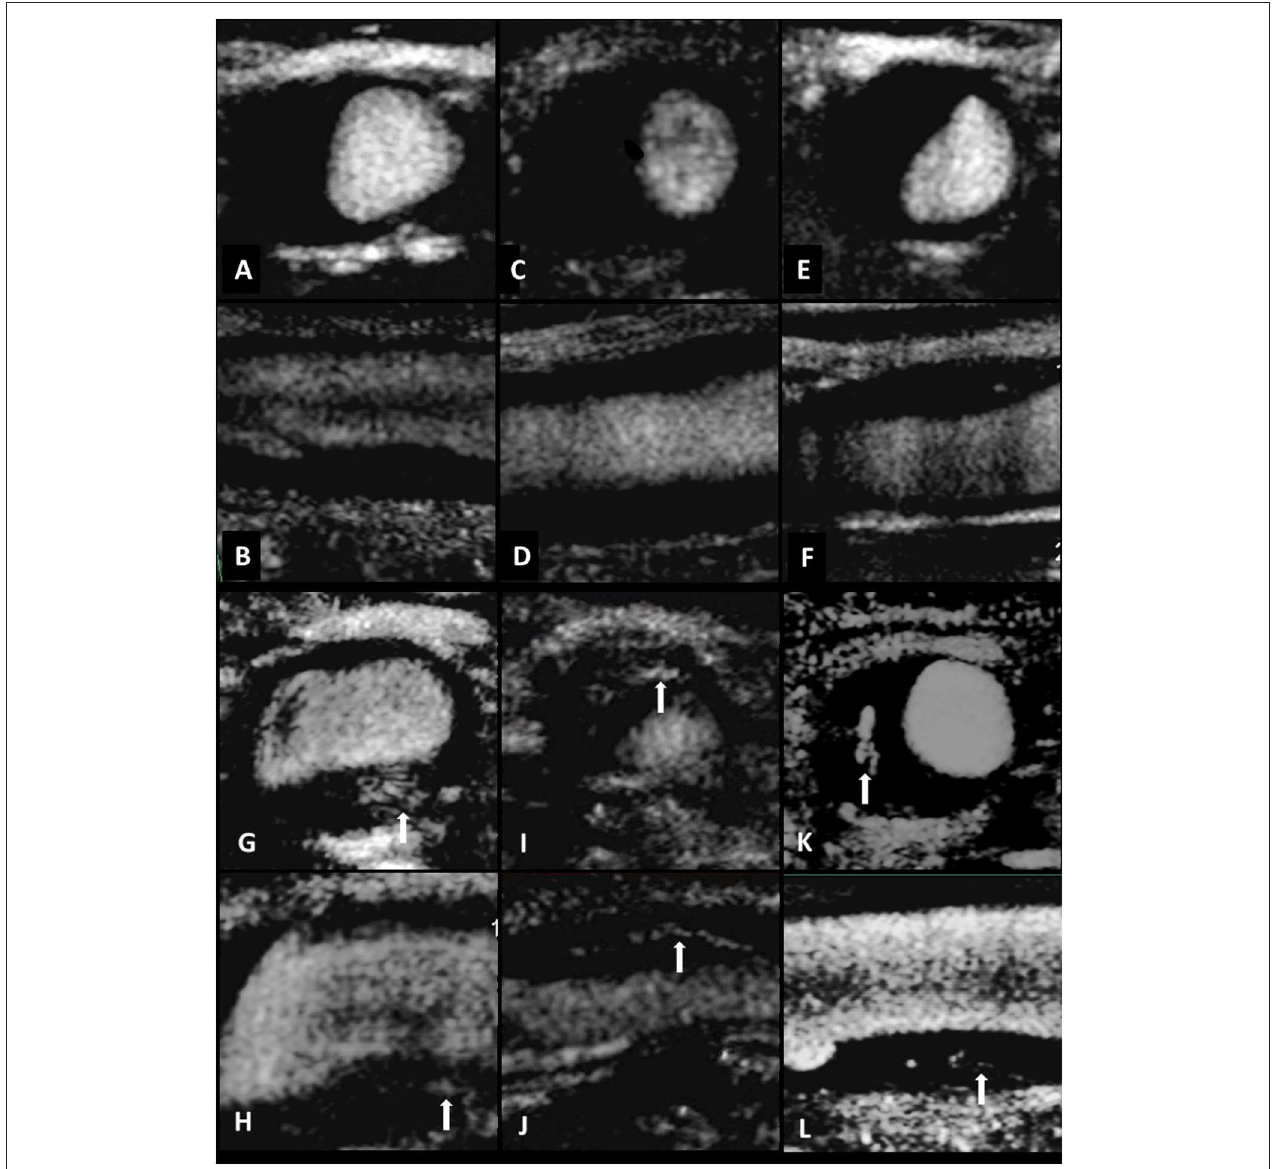
FIGURE 2 | Standard carotid artery plaque ultrasound and SMI in three individuals. Transverse and longitudinal carotid SMI ultrasound of the CCA (A–F) . Limited neovascularization was observed within the plaque, suggesting intraplaque vascularization of SMI Grade 1 (A–F) . Standard carotid artery plaque ultrasound and SMI in three individuals. Transverse and longitudinal carotid SMI ultrasound of the CCA (G–L) . Multiple short-line or strip-like hyperintense echo could be observed both in transverse and longitudinal direction. The arrows indicate moderate or marked neovascularization within the plaque, indicating intraplaque vascularization of SMI Grade 2 (G–L)